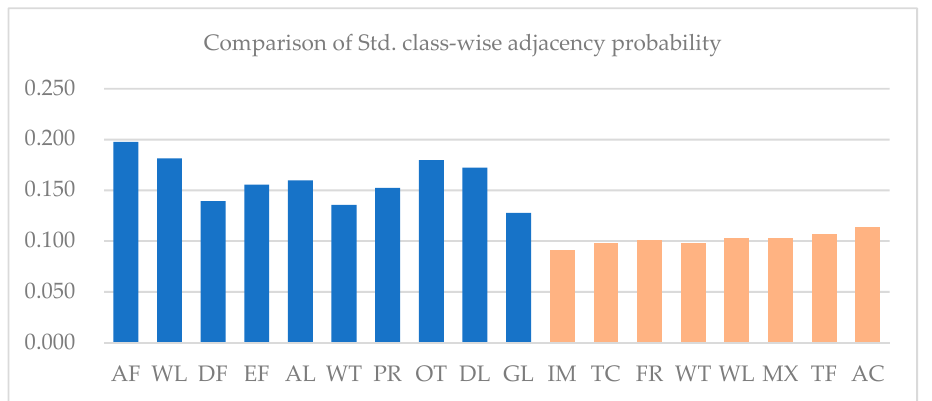
Figure 20. Comparison of standard deviation of class-wise adjacency probability in Kent County and the Mun River Basin.